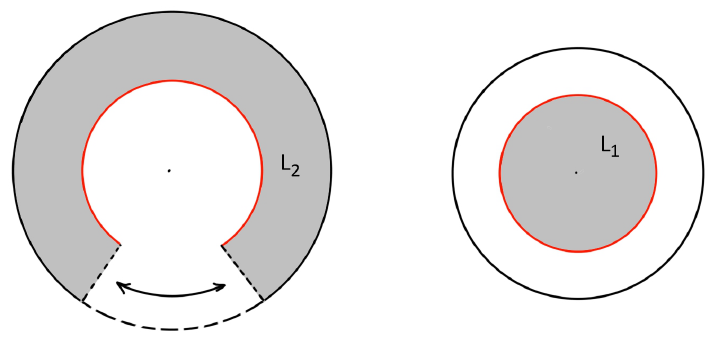
Figure 10. Possible geometry dual to a CFT on R d − 2 , 1 × S 1 with an interior bubble described by a different low-energy effective theory (see appendix